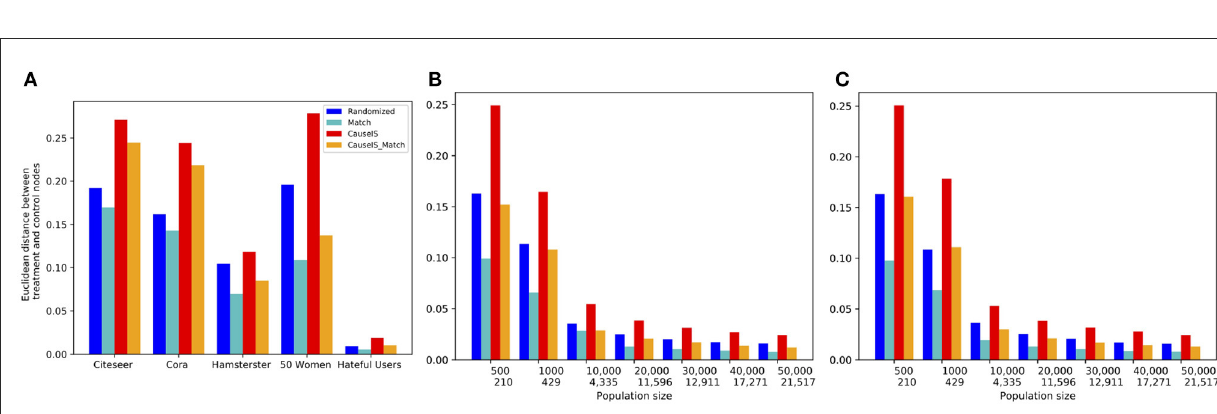
FIGURE7 Euclidean distance between the attribute vector means of treatment and control nodes in real-world and synthetic datasets. In synthetic dataset plots, numbers in the first row of the x-axis show the number of nodes in graphs, and in the second row show the size of MIS. (A) Real-world data, (B) Forest Fire model, and (C) Barab’asi-Albert